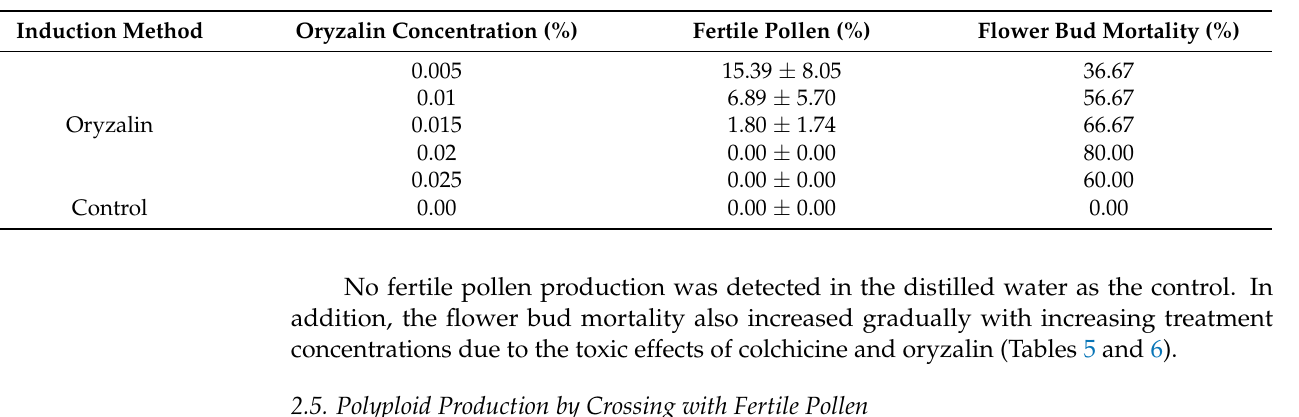
Table 6. Effects of oryzalin with different concentrations on fertile pollen induction for ‘Black Beauty’.